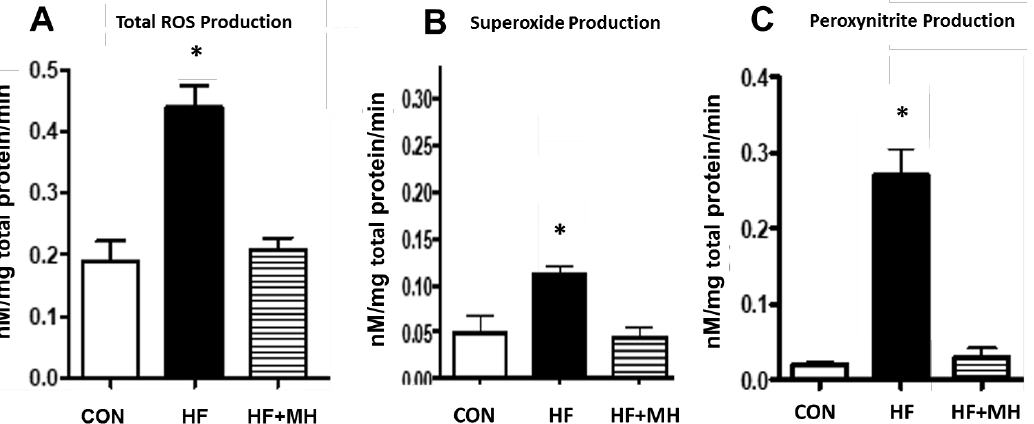
Figure 8. ( A ): Total reactive oxygen species (ROS) production; ( B ): superoxide production; ( C ): peroynitrite production measured by EPR in liver tissue of mice on diets for 9 months; Ns = 6–8; * = p < 0.001.